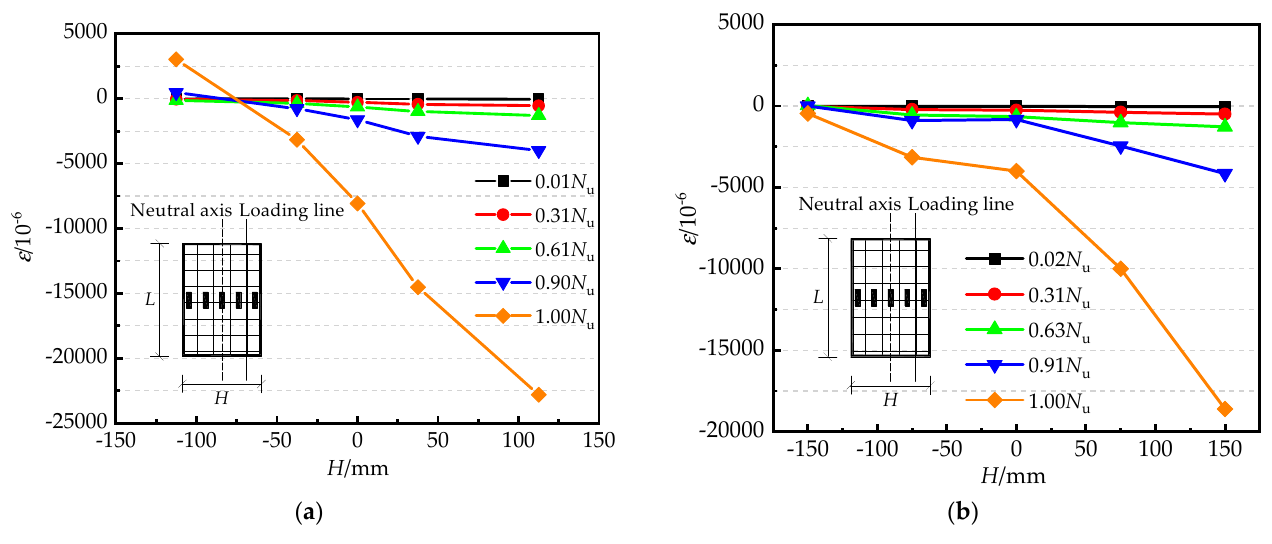
Figure 5. The strain curves of the normal section of the RRCFST columns: ( a ) PY0.5 − 180 − e2; ( b ) PY1 − 180 − e1 − Q235.